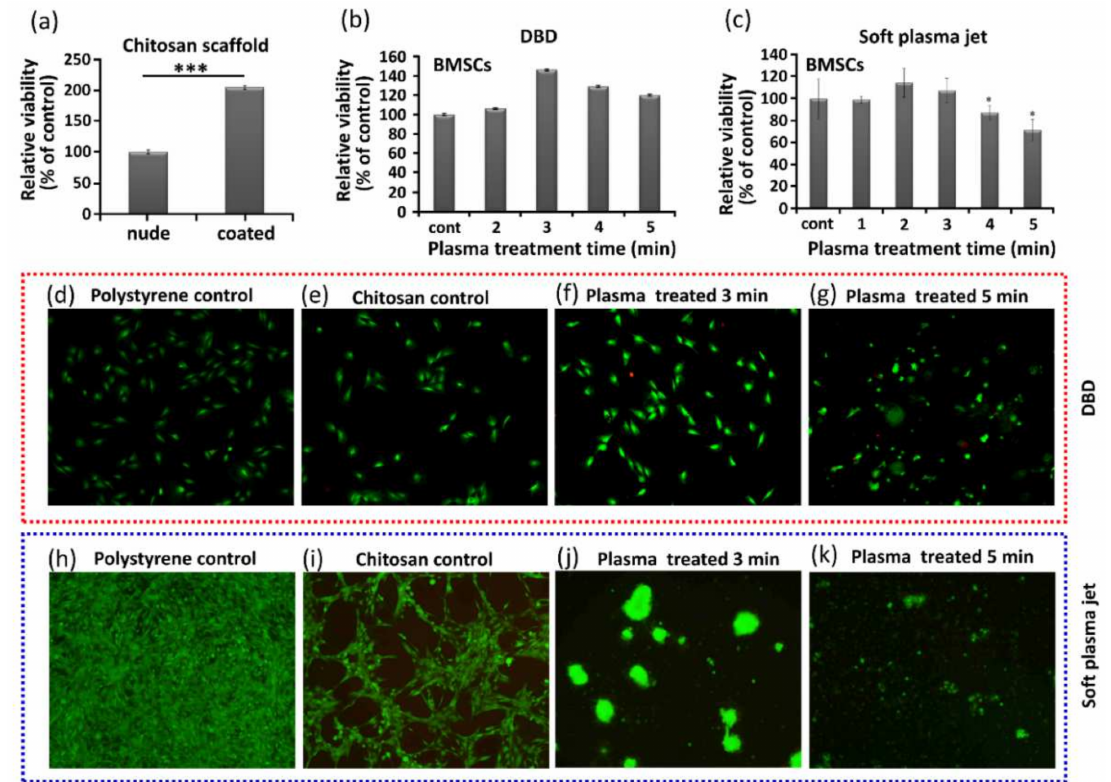
Figure 2. Effect of Non-thermal, biocompatible plasma (NBP) on the viability of bone marrow-derived stem cell (BMSC) cultured on chitosan scaffolds. ( a ) Viability of nude and coated cell cultures (i.e., without and with chitosan), ( b ) viability of BMSCs with DBD-based NBP treatment, ( c ) viability of BMSCs with soft plasma jet-based NBP treatment. Live/dead staining to show cell viability of cells cultured on ( d ) polystyrene, as control, ( e ) untreated chitosan scaffold, as control, ( f ) 3-min DBD-based NBP treated chitosan scaffold, ( g ) 5-min DBD-based NBP treated chitosan scaffold, ( h ) polystyrene, as control, ( i ) untreated chitosan, as control, ( j ) 3-min soft plasma jet-based NBP treated chitosan scaffold, and ( k ) 5-min soft plasma jet-based NBP treated chitosan scaffold. Significant differences were indicated as * p < 0.05, and *** p < 0.0001 by Tukey test after one-way analysis of variance. Data are presented as mean ± SD from three independent